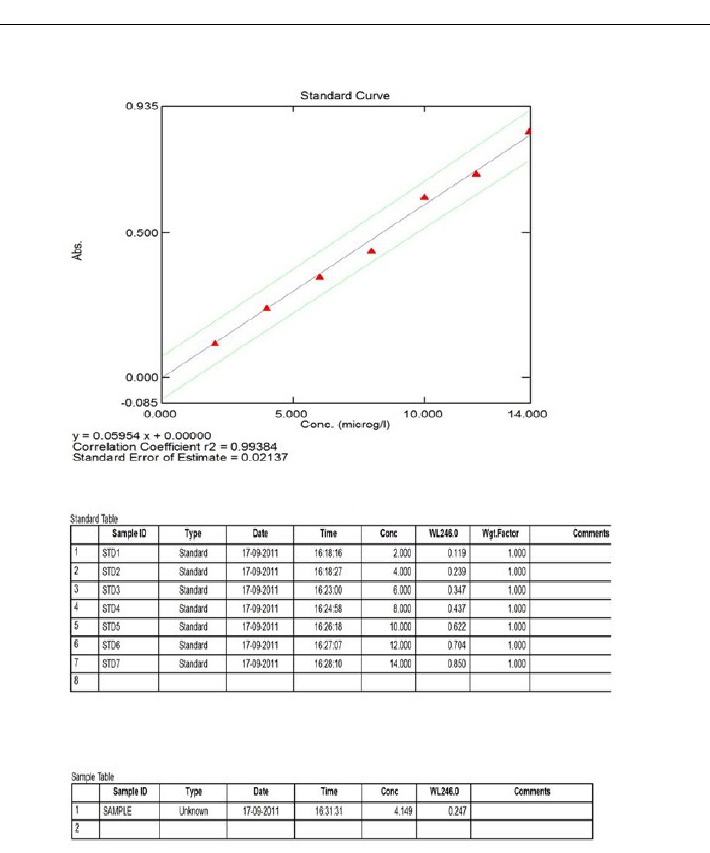
Figure 2: Calibration Curve of Standard